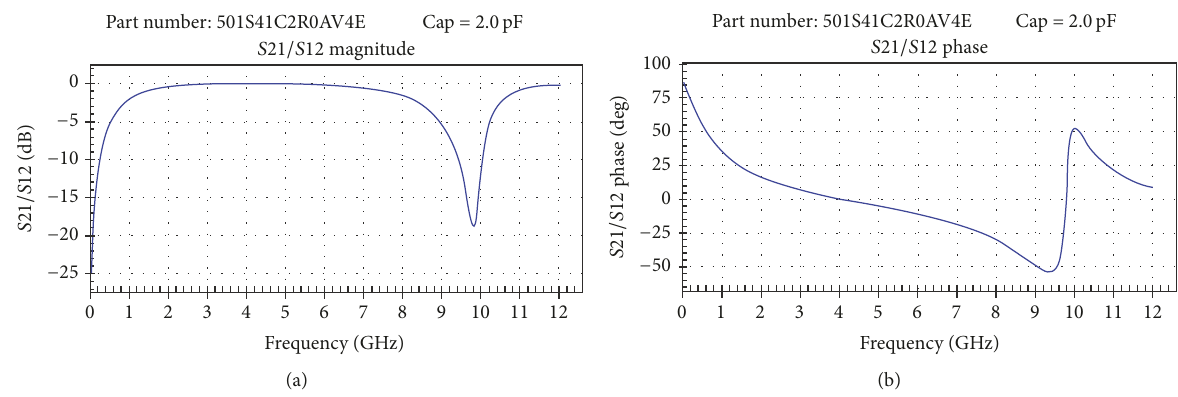
Figure 12: The reference S -parameters of the 2.0 pF capacitor provided by Johanson Technology: (a) magnitude and (b) phase.